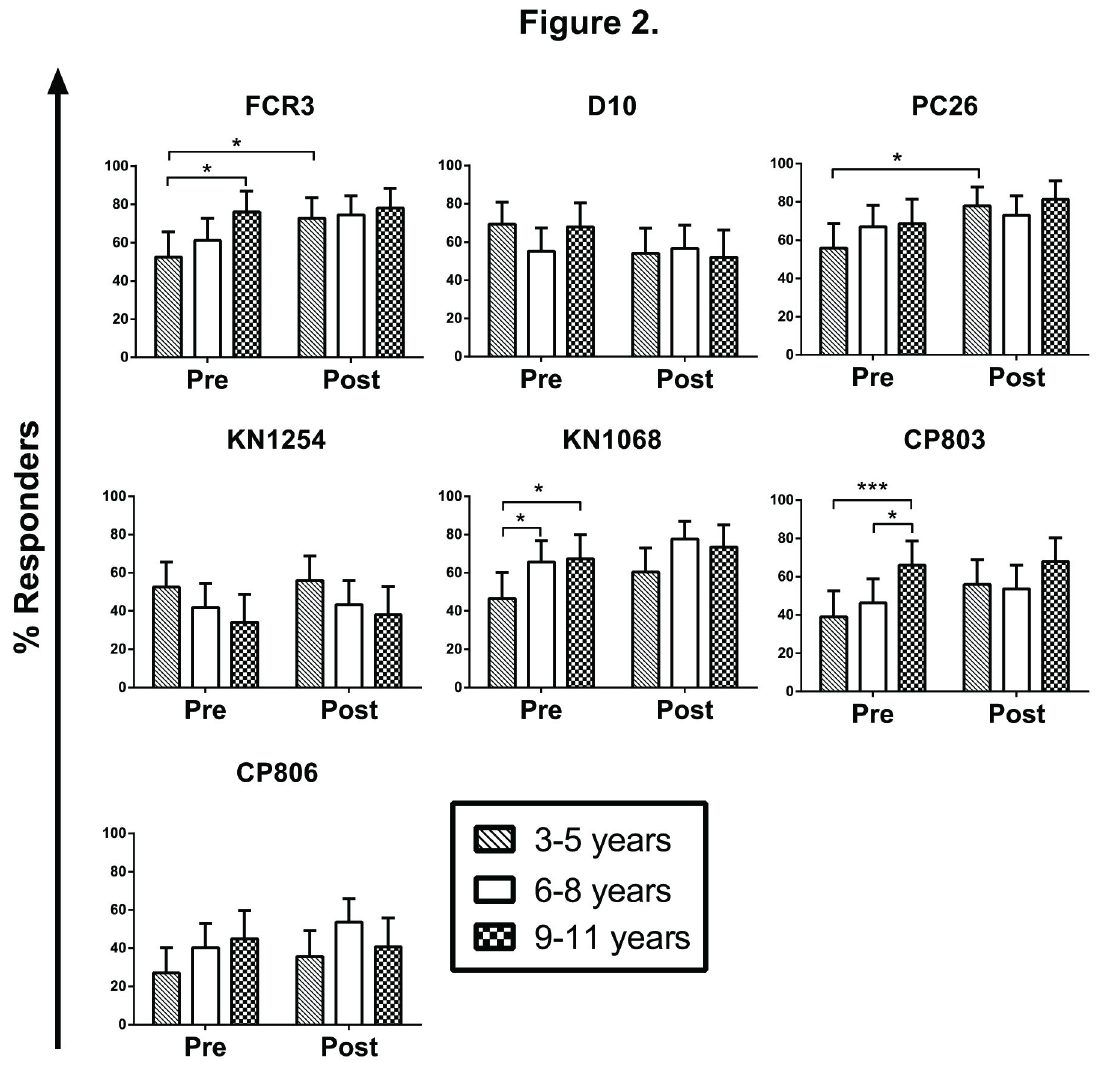
Figure 2. Effect of age on IgG recognition of different parasite strains. The proportions of children responding to each parasite strain were compared between age groups, before and after the transmission season. The age effect at each time point was evaluated using Chi-square likelihood ratio test; significant findings were then confirmed by Odds ratio test. The seasonal effect in each age group was evaluated using Fisher’s exact test. *p<0.05, **p<0.01, ***p<0.001. Error bars shown are the upper 95% Confidence Interval for the % responder